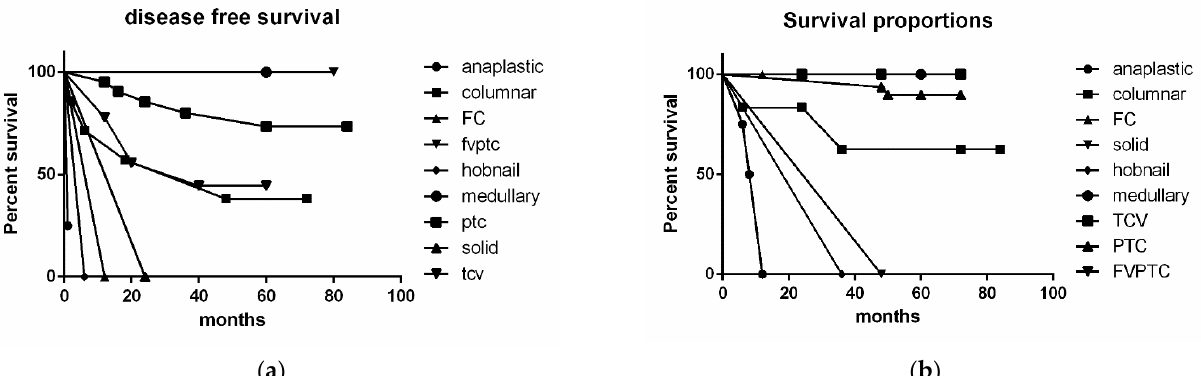
Figure 3. ( a and b ): ( a ): Distribution of thyroid cancer histotypes and disease-free survival (Figure Figure 3. ( a ): Distribution of thyroid cancer histotypes and disease-free survival; ( b ): distribution of 3a); ( b ): distribution of thyroid cancer histotypes and survival proportions. thyroid cancer histotypes and survival proportions.